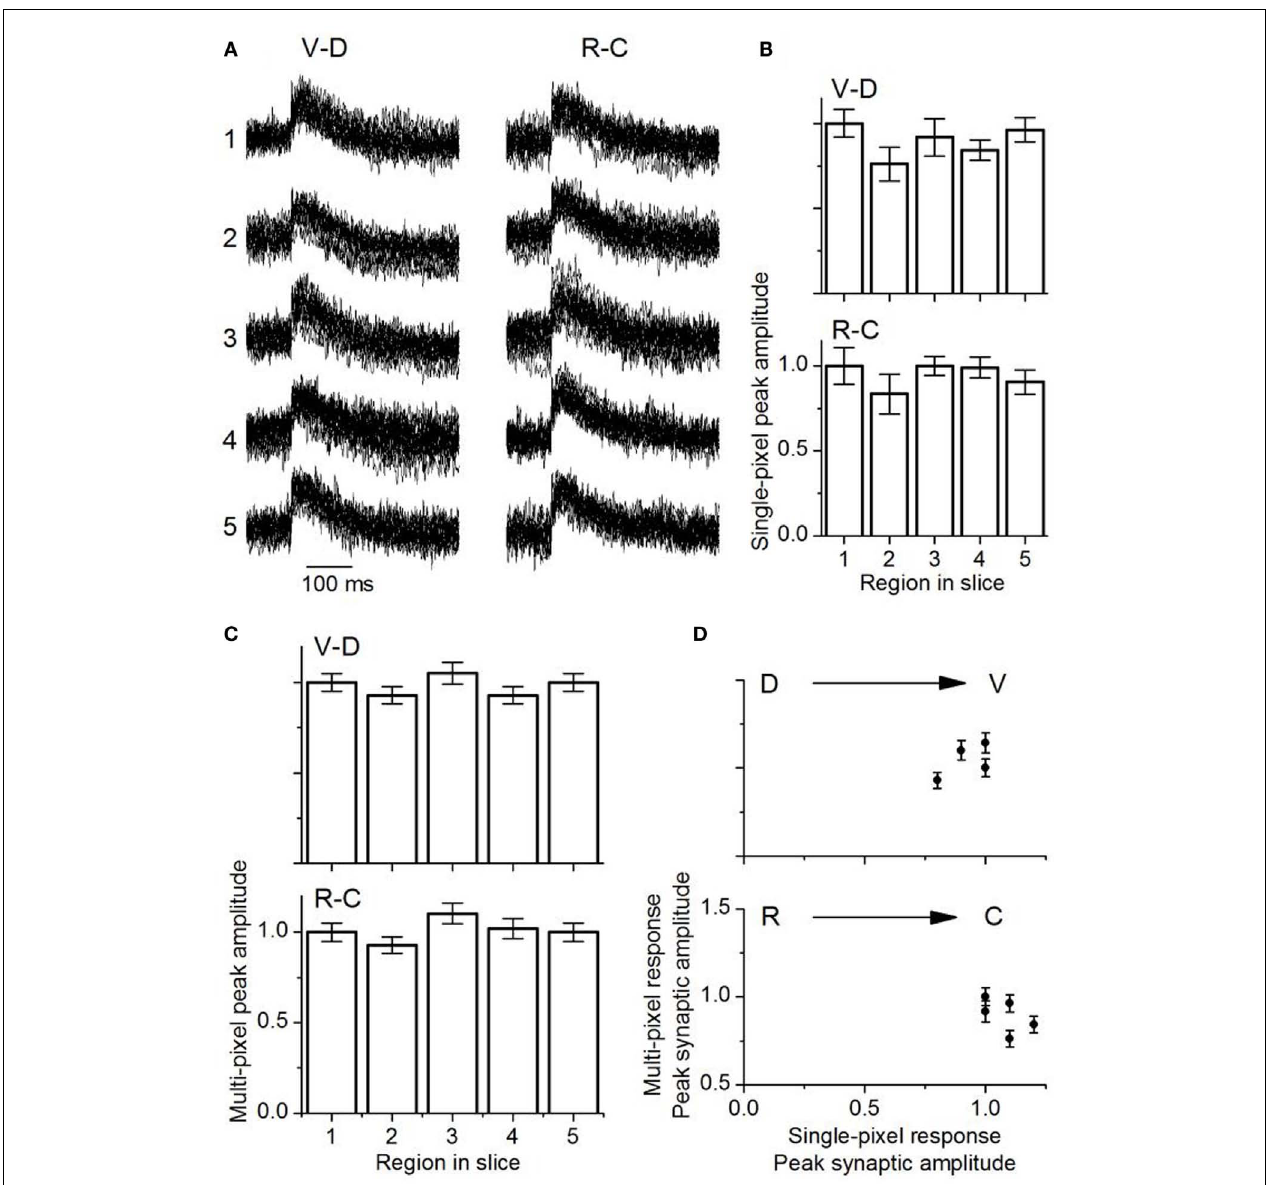
amplitudes in each direction as indicated (18 slices; SEM.). (C) Mean multi-pixel peak amplitudes in each direction as indicated (18 slices; SEM.). (D) Multi-pixel peak amplitudes as a function of the average single pixel peak amplitude in the dorso-ventral and rostro-caudal directions.The second and fourth data points in the dorso-ventral plot overlap. Averages of 18 slices. Error bars are